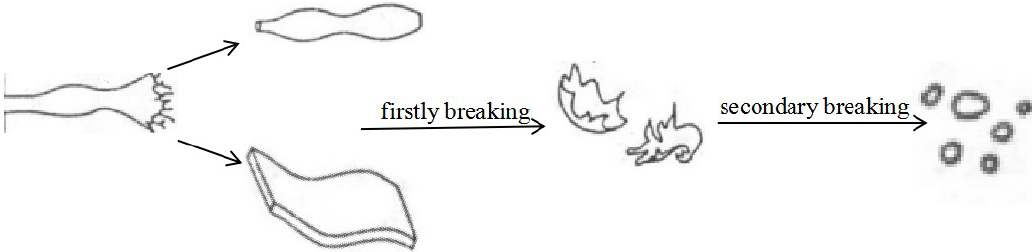
Figure 2. Gas quenching mechanism diagram.